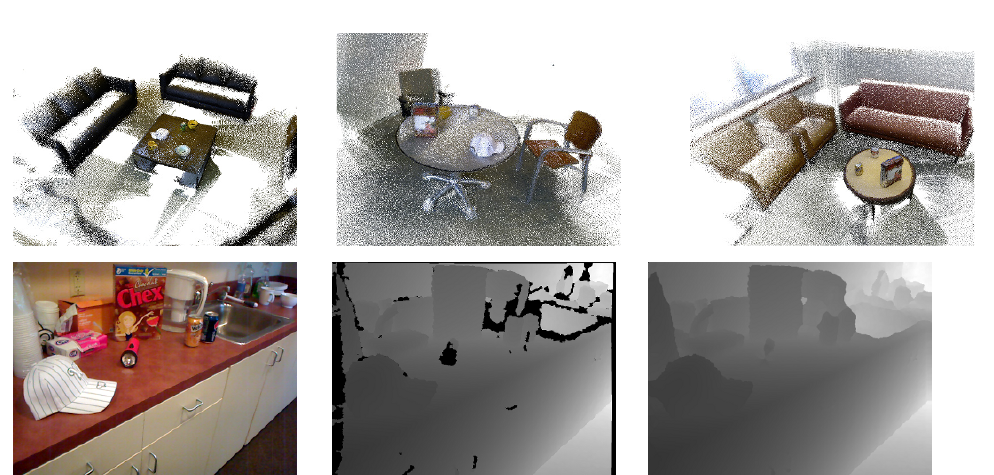
Figure 6. Washington RGB-D Object Dataset